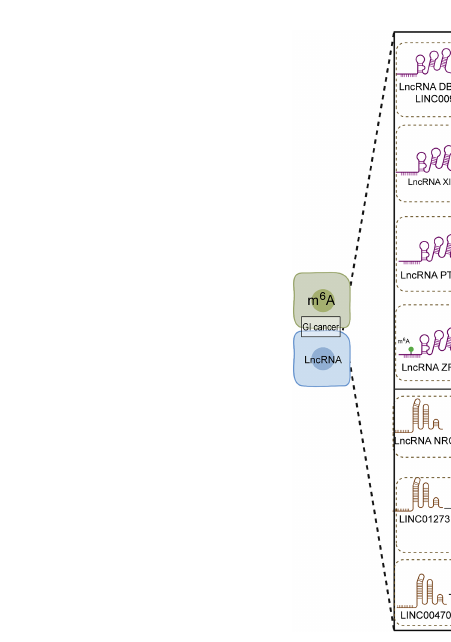
FIGURE 1 Interplay between lncRNAs and m6A in gastrointestinal